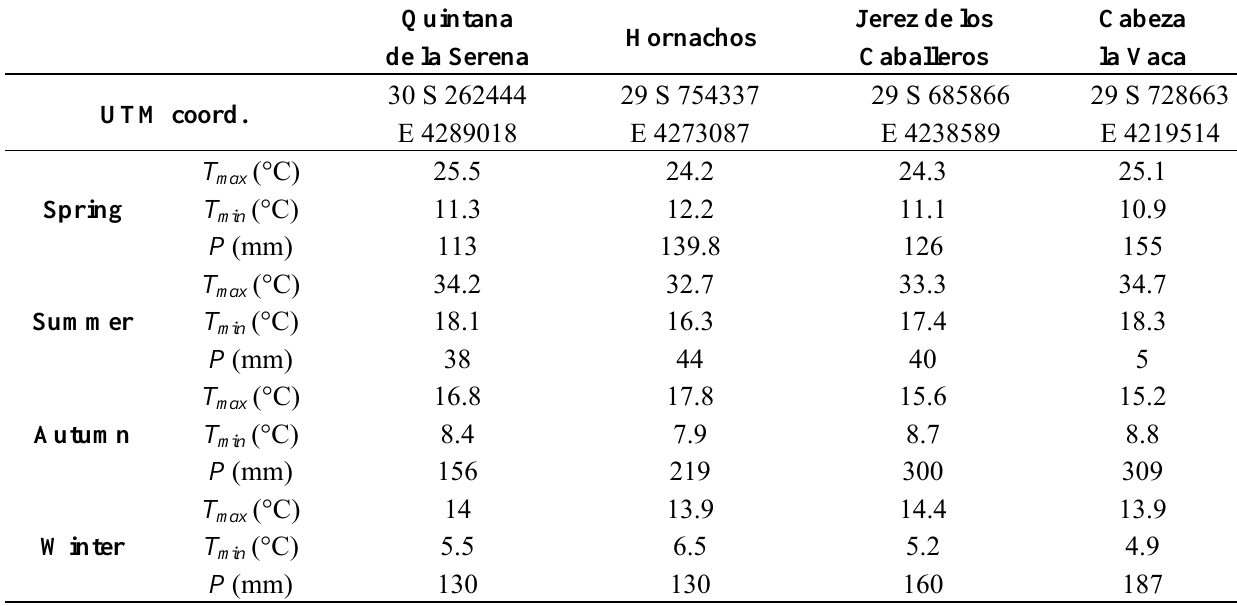
Table 3. Values for the four populations selected for sample collection of: T the seasonal maximum temperatures (°C); T temperatures (°C); P: total seasonal rainfall (mm). Location UTM